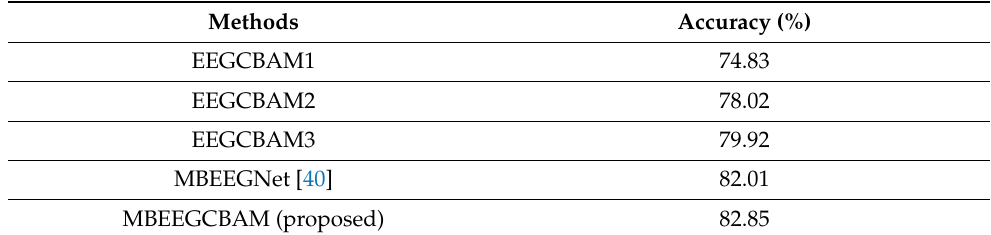
Table 3. The classification performance in different models. Methods